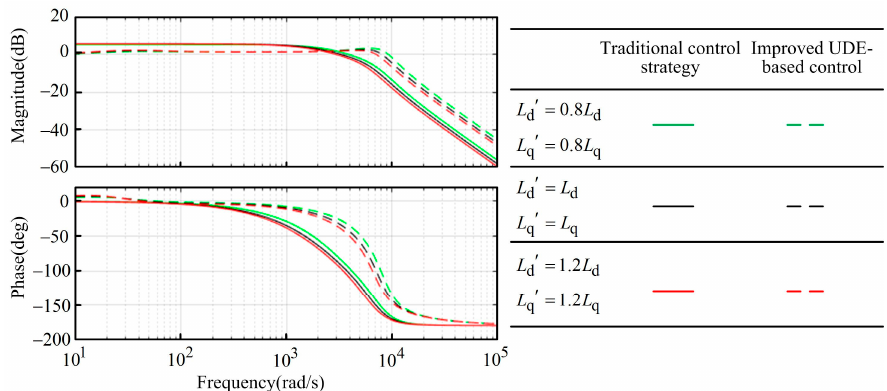
Figure 7. Bode plots of current loops.